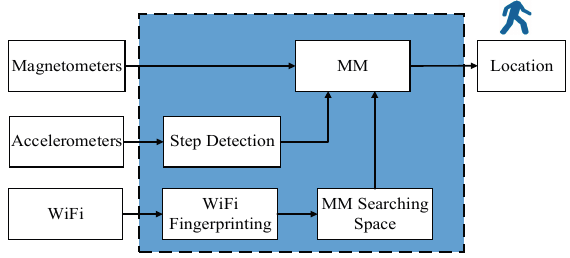
Figure 1. Algorithm